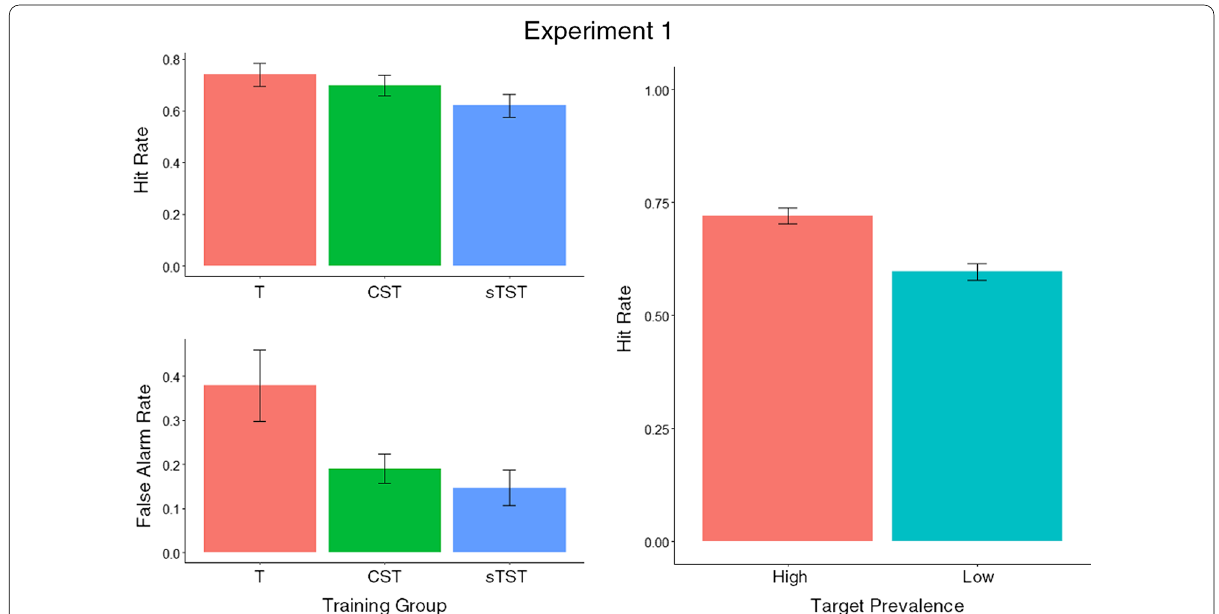
Fig. 4 Hit rate and false alarm rate by training group, prevalence and overlap conditions corresponding to LMM analysis for Experiment 1 (target‑based search training [T], standard targetless search training [sTST] and combined search training [CST]), error bars show 95%